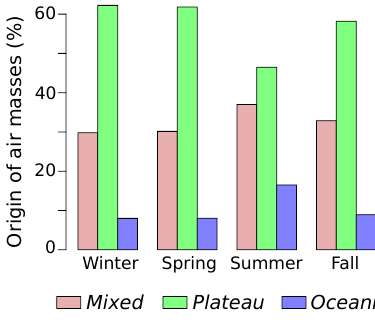
Figure 4. Mean percentage (%) of continental/oceanic mixed air masses (pink), and of air masses originating from the Antarctic plateau (green) or the ocean (blue) according to the